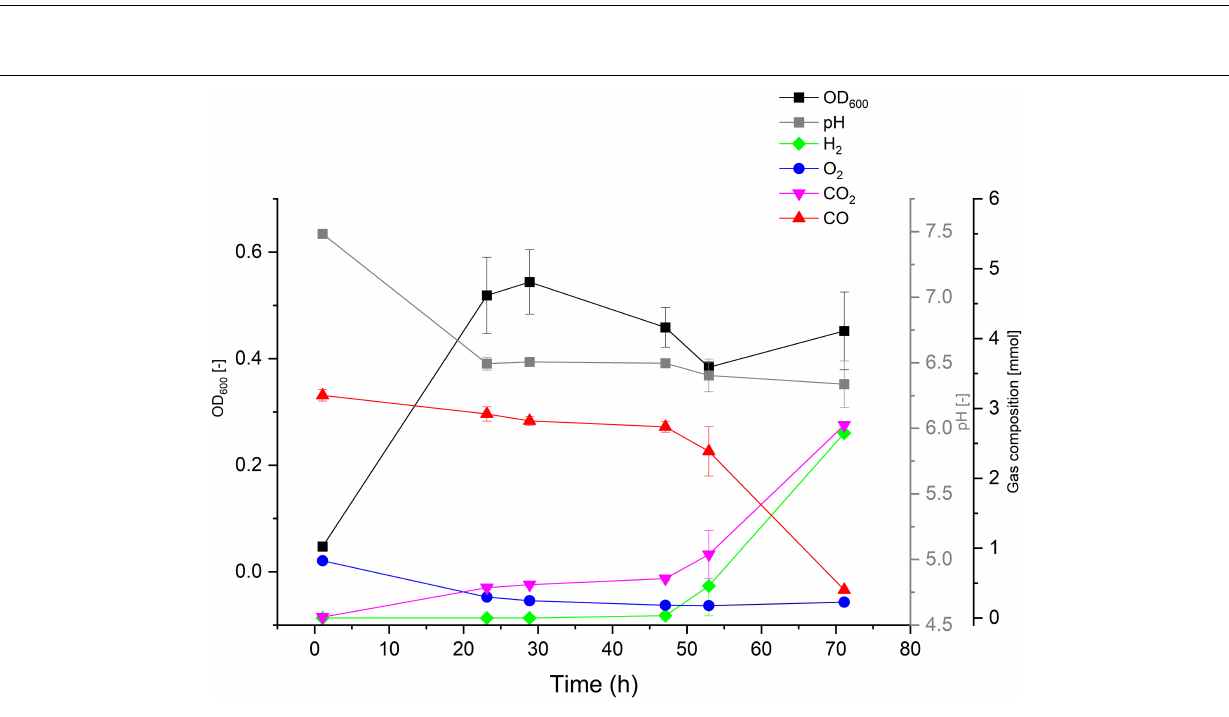
Frontiers in Microbiology |